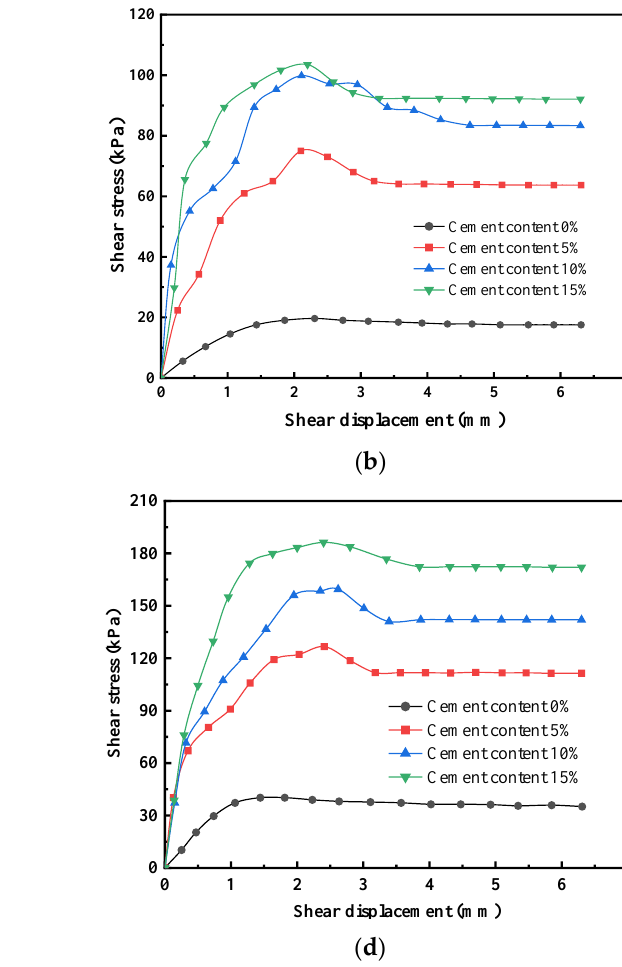
Figure 4. Curves of shear stress and shear displacement of muddy clay. ( a ) σ = 50 kPa. ( b ) σ = 100 kPa. ( c ) σ = 200 kPa. ( d ) σ = 400 kPa.